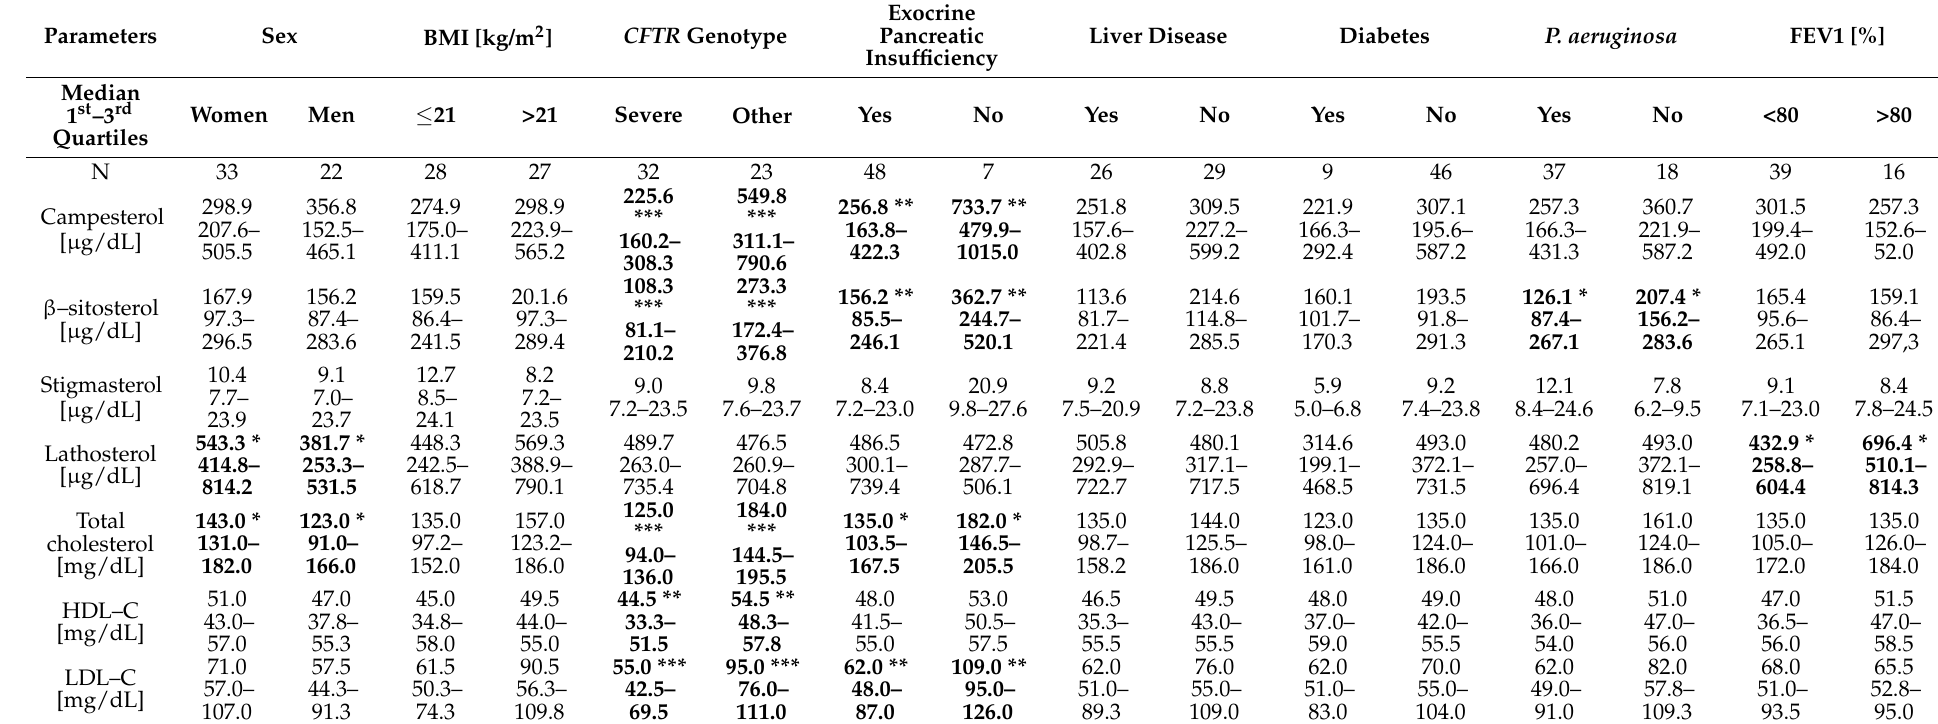
Table 4. Sterol concentrations in subgroups of cystic fibrosis patients defined by different clinical parameters.